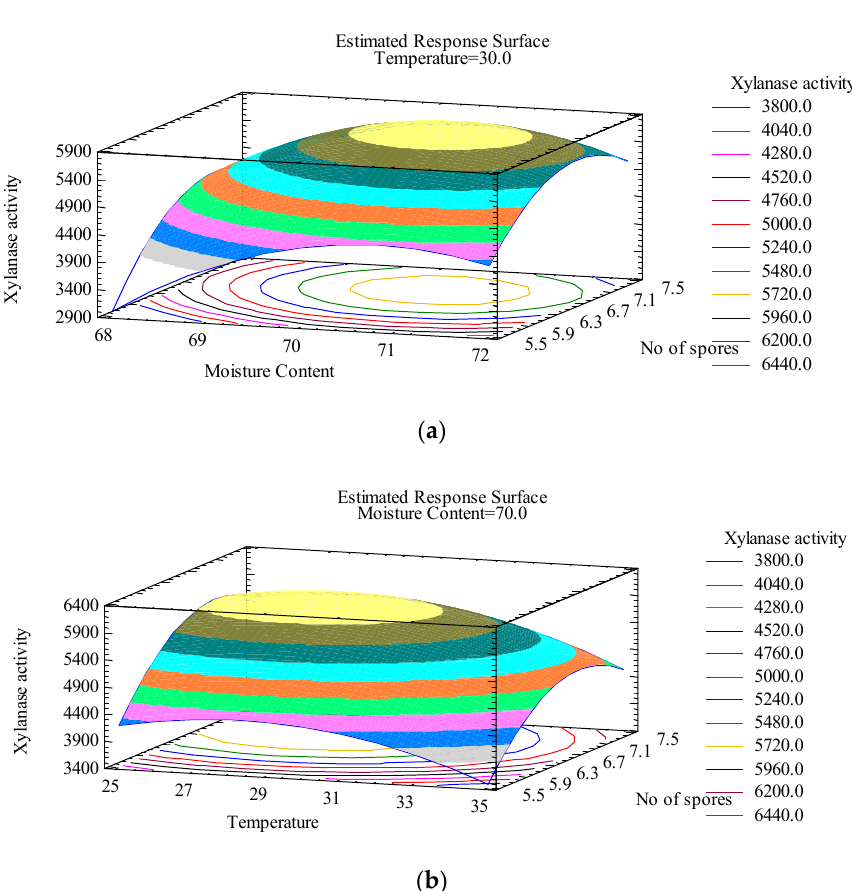
Figure 1. Response surface plots representing the effect of independent variables on xylanase activity: ( a ) The effect of inoculum size (log number of spores) and moisture content (%) when response surface is fixed at temperature = 30 °C; ( b ) the effect of inoculum size (log number of spores) and temperature (°C) when response surface is fixed at moisture content = 70%.